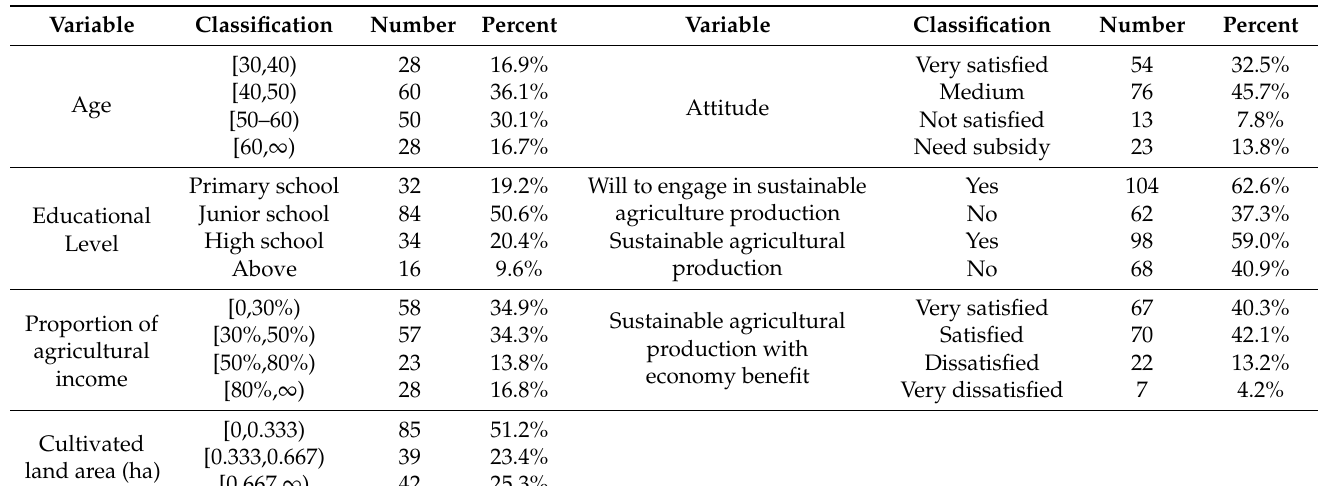
Table 3. Descriptive statistics of the surveyed participants.